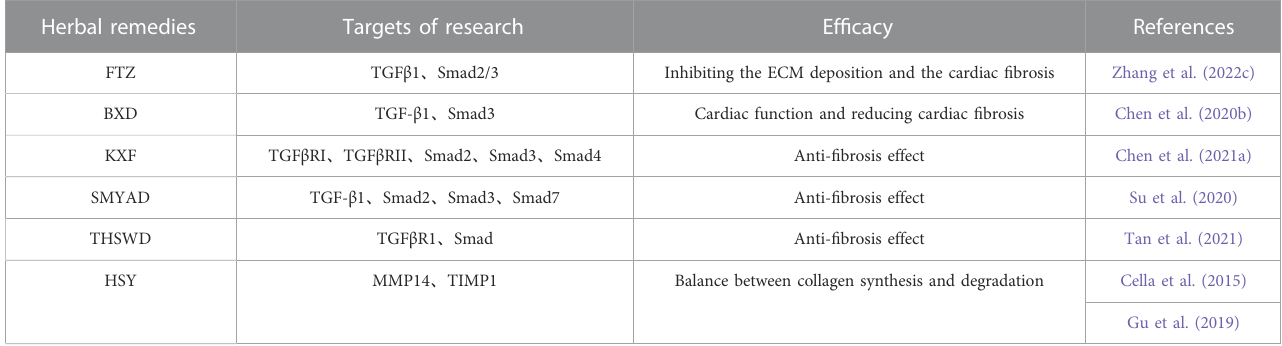
TABLE 5 Mechanism of Chinese herbal medicine regulating TGF-signaling pathway and intervening cardiac fi brosis. Herbal